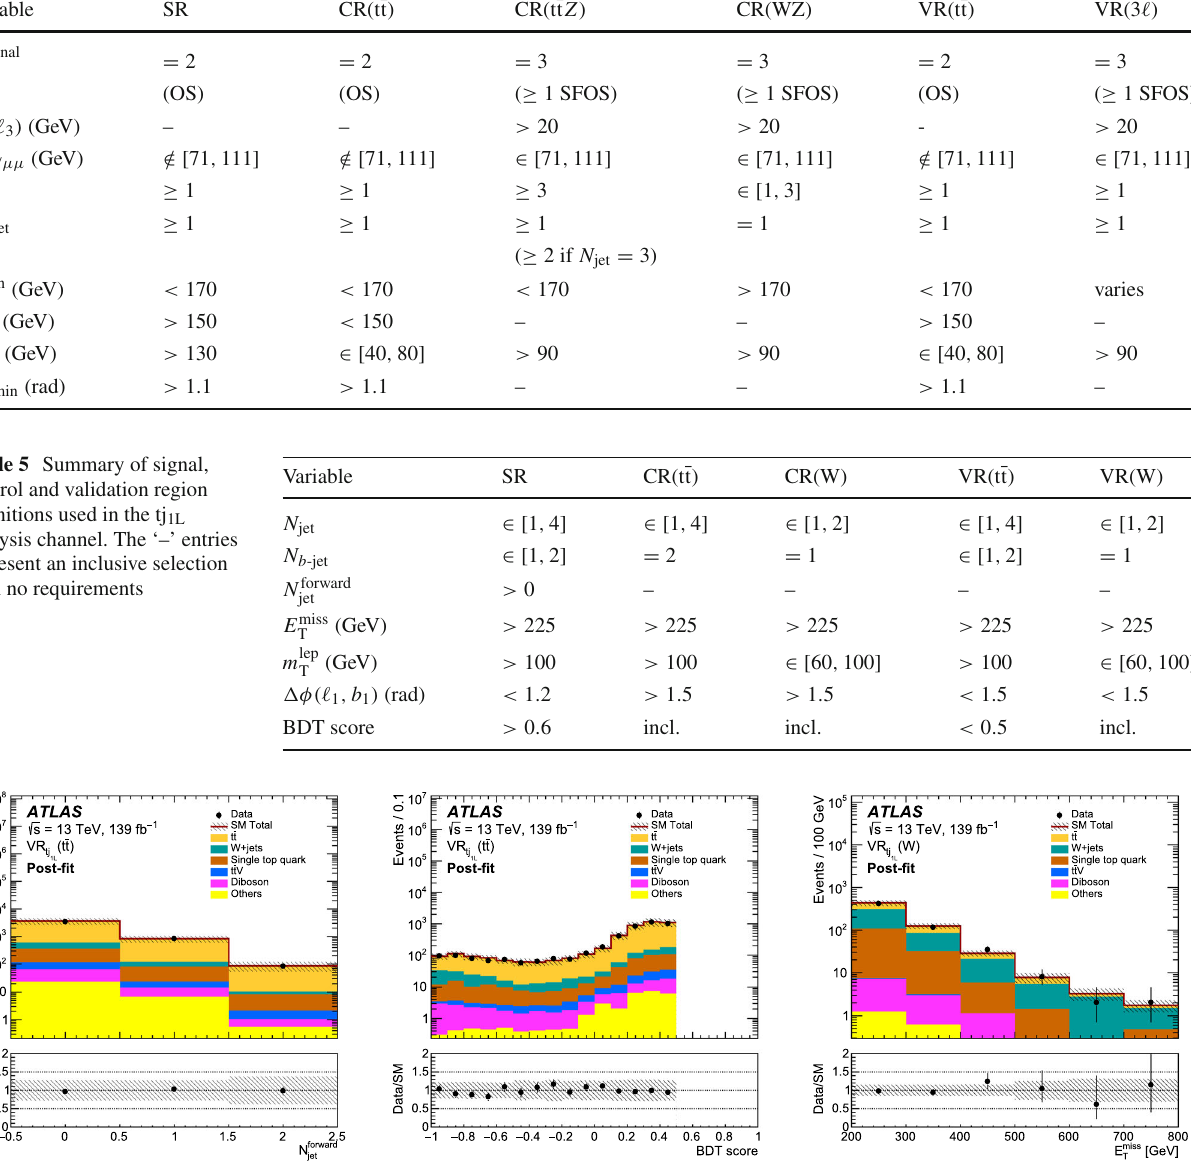
Table 4 Summary of signal, control and validation region definitions used in the tW 2L analysis channel. The ‘–’ entries represent an inclusive selection with no requirements. In the final states with three leptons, the corrected E miss , m min and m T2 variables are used instead as described b (cid:7) T